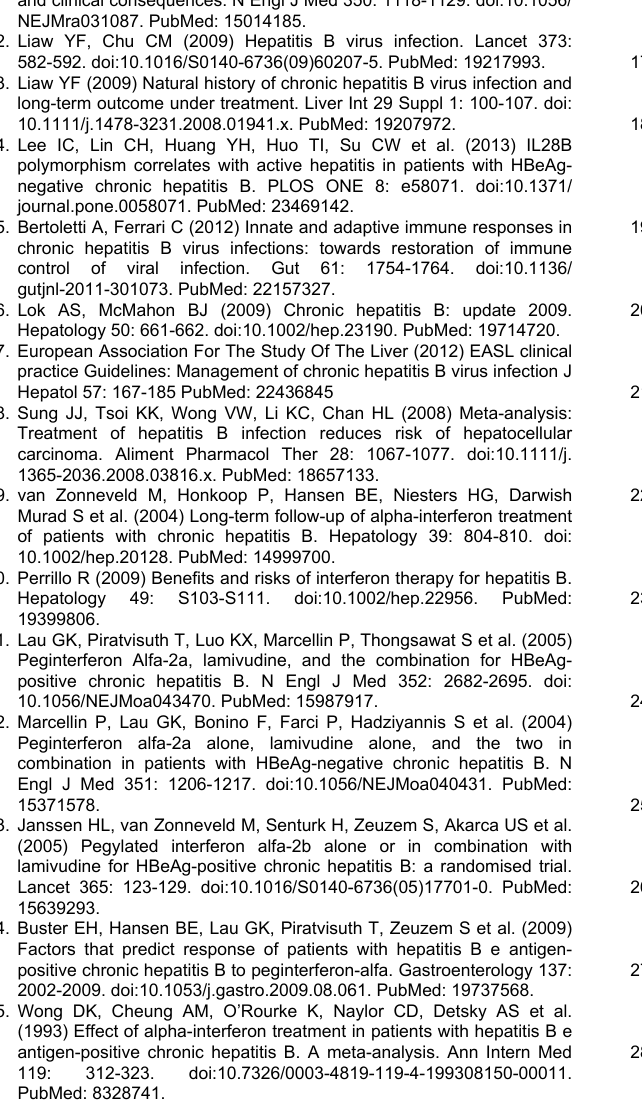
Table S1. Univariate and multivariate analyses of factors associated with sustained virological response in HBeAg- positive patients (n=36).